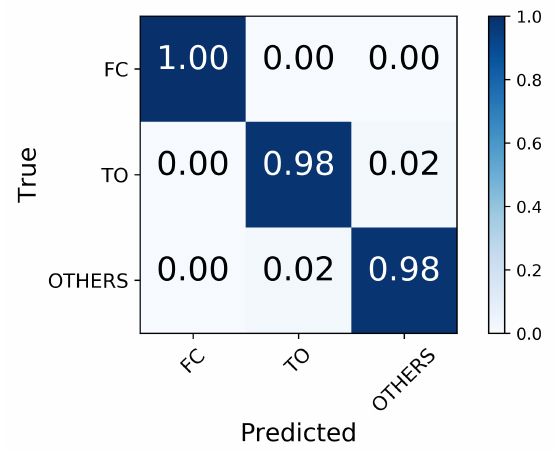
Figure 2. Confusion matrix for FC and TO